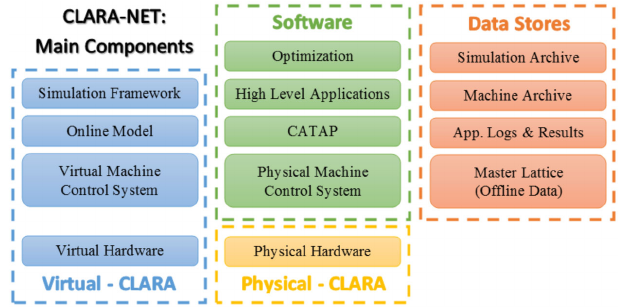
FIG. 29. Schematic of the connections between the physical and virtual accelerators, the low-, mid-, and high-level control interfaces, and the machine ’ s data